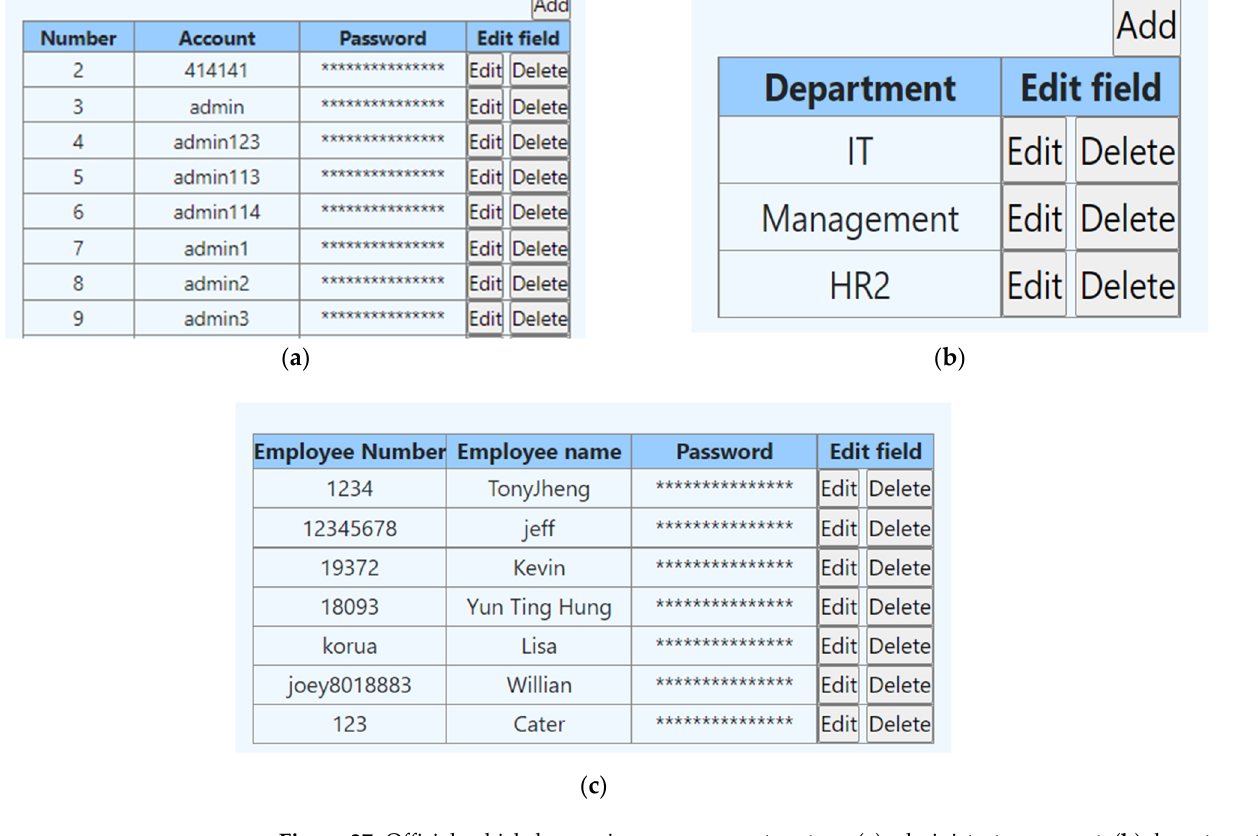
Figure 37. Official vehicle borrowing management system: ( a ) administrator account; ( b ) department account. ( c ) Employee account. (* covert password).